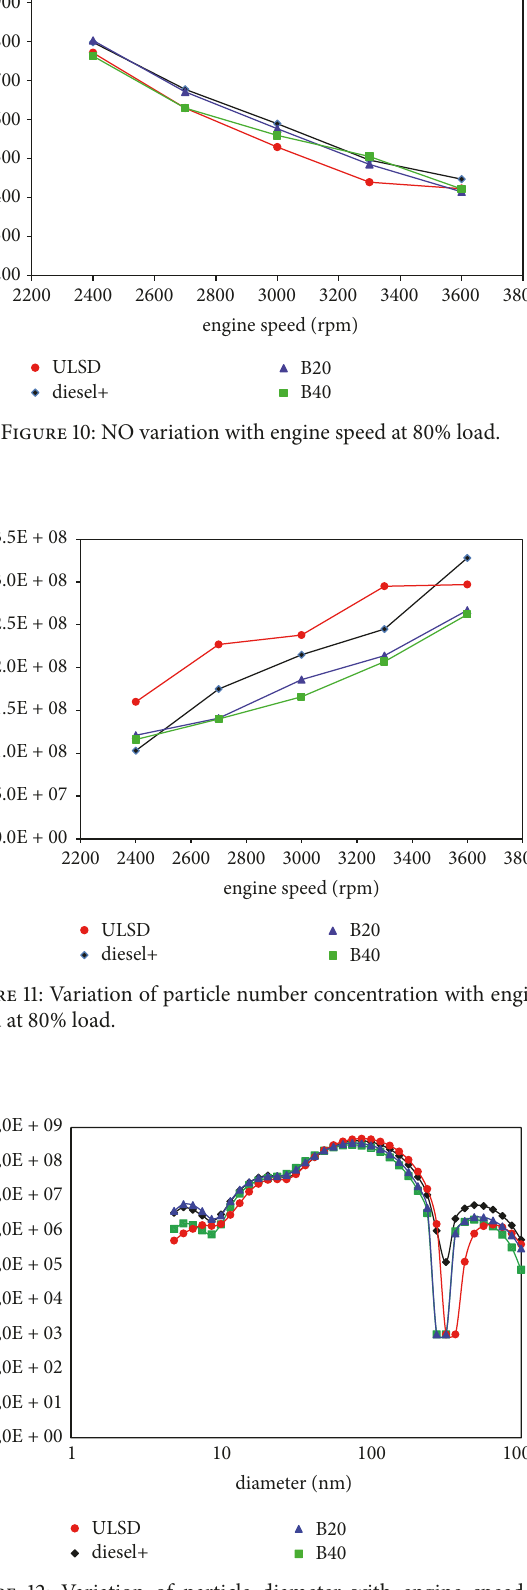
Figure 12: Variation of particle diameter with engine speed at 3000 rpm and 80% load (18Nm).